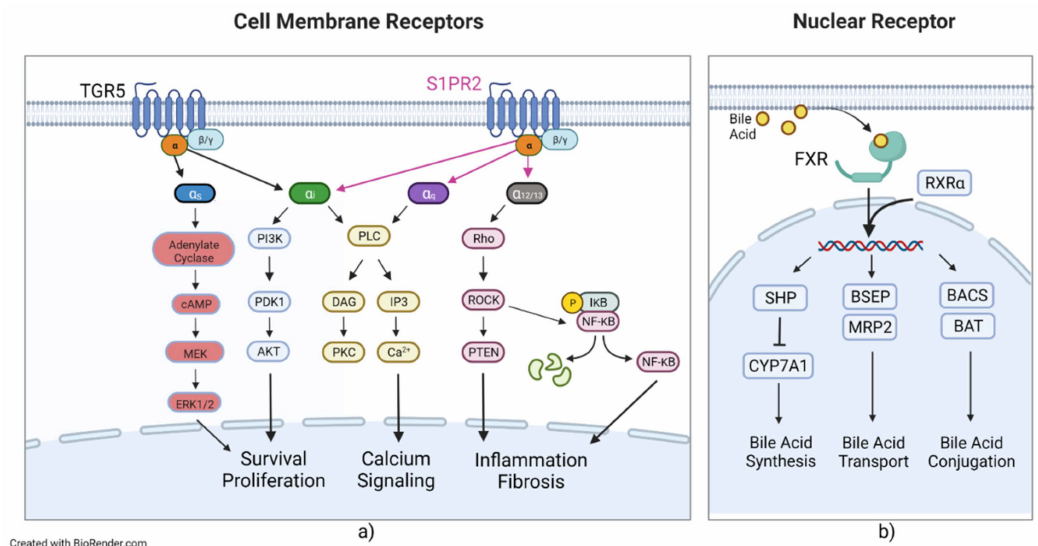
Figure 3. Bile acid signaling, surface-localized and nuclear-localized. ( a ) Graphical representation of cell membrane receptors for bile acids, highlighting signaling through the Takeda G protein-coupled receptor 5 (TGR5), sphingosine-1-phosphate receptor 2 (S1PR2), and G protein-coupled receptors.